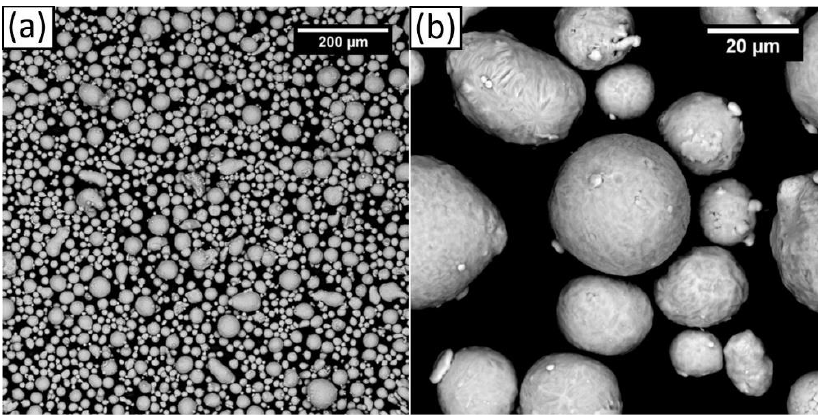
Figure 1. F357 powder at ( a ) 300× and ( b ) 3000×.